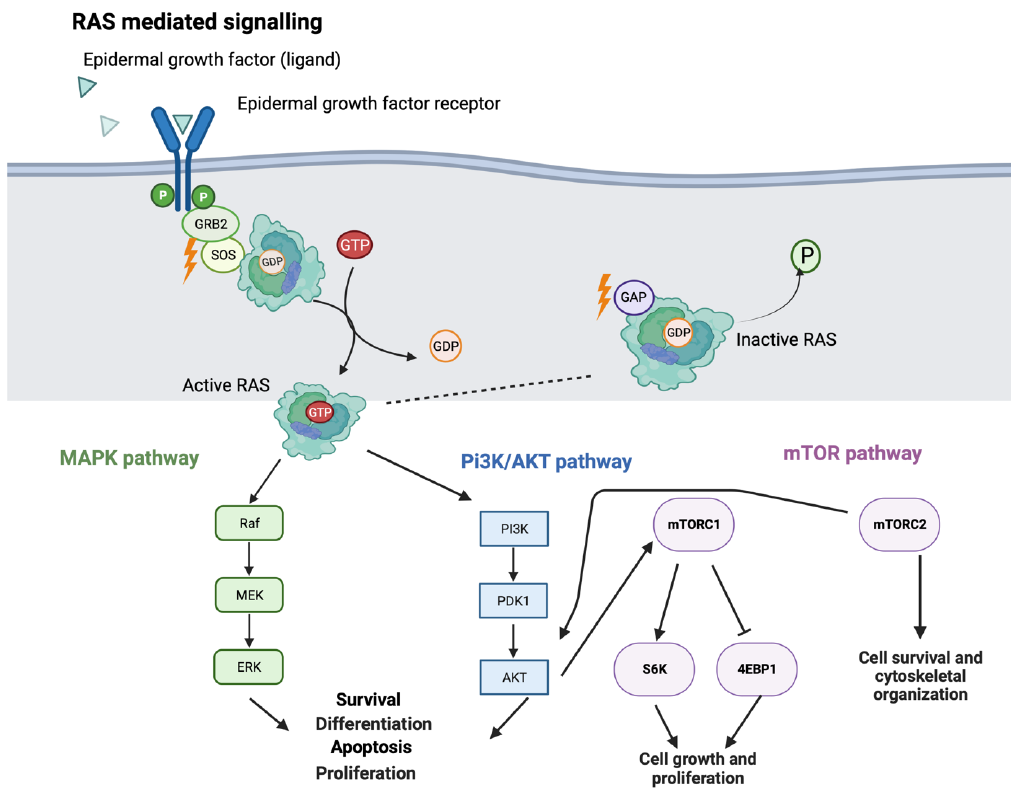
Figure 1. RAS-mediated signaling pathway. Signaling begins with a ligand such as the epidermal growth factor (EGF) binding to a receptor tyrosine kinase such as the EGF receptor (EGFR). This binding activates downstream guanine nucleotide exchange factor (GEF) proteins such as the son of sevenless (SOS) protein to mediate cycling of GDP to GTP on RAS proteins. This cycling induces a conformational change that allows for binding with downstream signaling components. RAS once activated can bind RAF and signal through the mitogen-activated pathway kinase (MAPK) pathway or bind to phosphatidylinositol-3 kinase (PI3K) and signal through the PI3K pathway. The PI3K pathway can then activate or be activated by the mammalian target of rapamycin (mTOR) pathway. The downstream effect of these pathways leads to transcriptional reprogramming, affecting cellular survival, differentiation, apoptosis, and proliferation. The signaling of RAS is controlled by intrinsic GTPase activity that is catalyzed by a GTPase-activating protein (GAP) to hydrolyze the GTP into GDP and induce RAS into its inactive